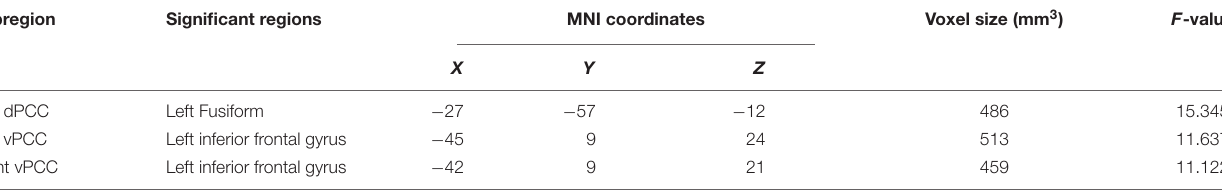
TABLE 2 | The areas of significantly different dFC among the SI, NSI, and HCs group (voxel p < 0.005, cluster p < 0.0125, GRF corrected).